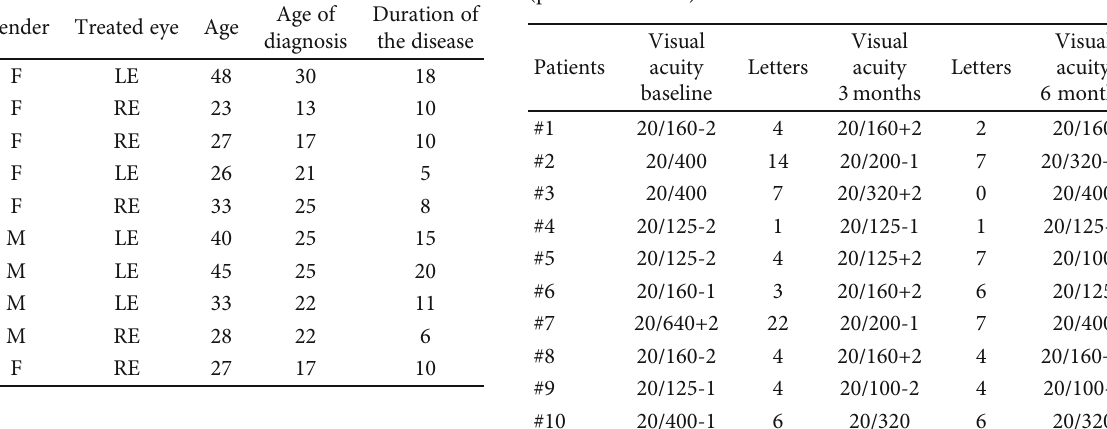
Table 1: Patient data such as gender, treated eye, age, age of diagnosis, and duration of the disease.